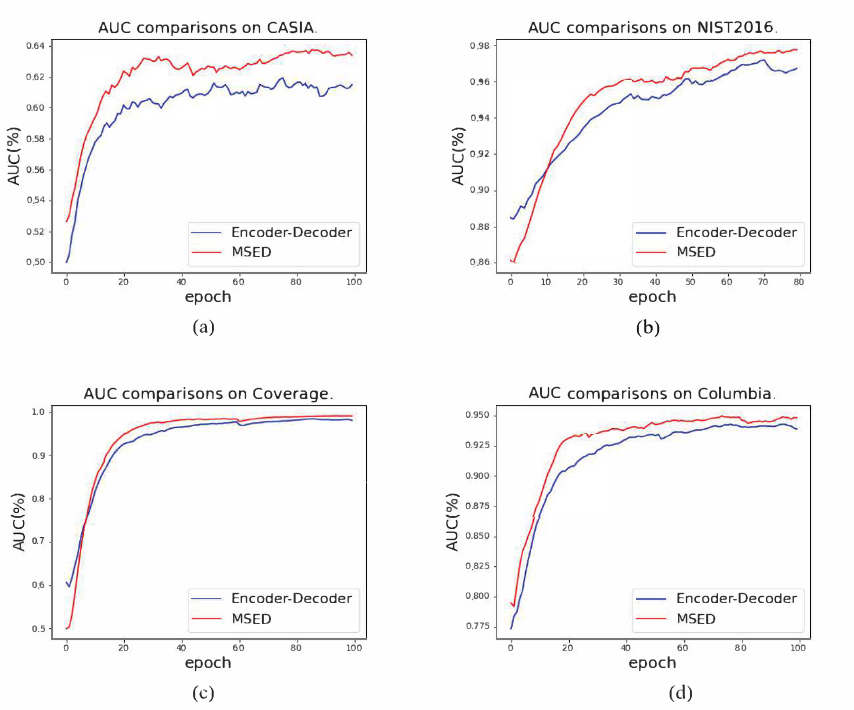
Figure 8. AUC (%) comparisons of MSED variants evaluated on CASIA ( a ), NIST2016 ( b ), Coverage ( c ), and Columbia ( d ). In each sub-graph, the blue curve represents the results of the basic encoder– decoder network, while the red curve means the results of the our proposed MSED model with additional multi-supervised